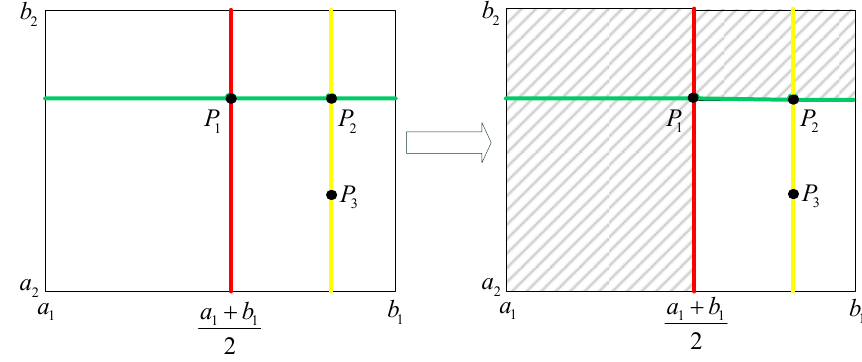
Figure 3. The general idea of the constrained two ‐ dimensional optimum seeking method, a 1 and b 1 are the lower and upper limits for the feasible region of the first parameter, respectively; a 2 and b 2 are the lower and upper limits for the feasible region of the second parameter, respectively, P 1 , P 2, and P 3 are corresponding optimal points for different iterative steps.